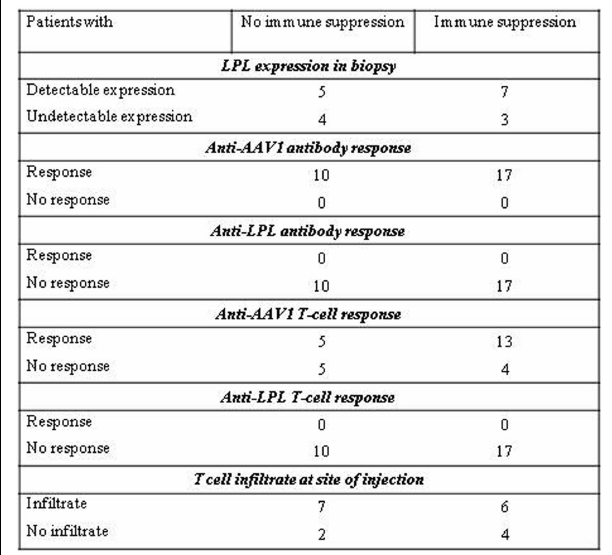
FIGURE 6 | Effect of immune suppression on LPL-expression and immune responses upon administration of alipogene tiparvovec